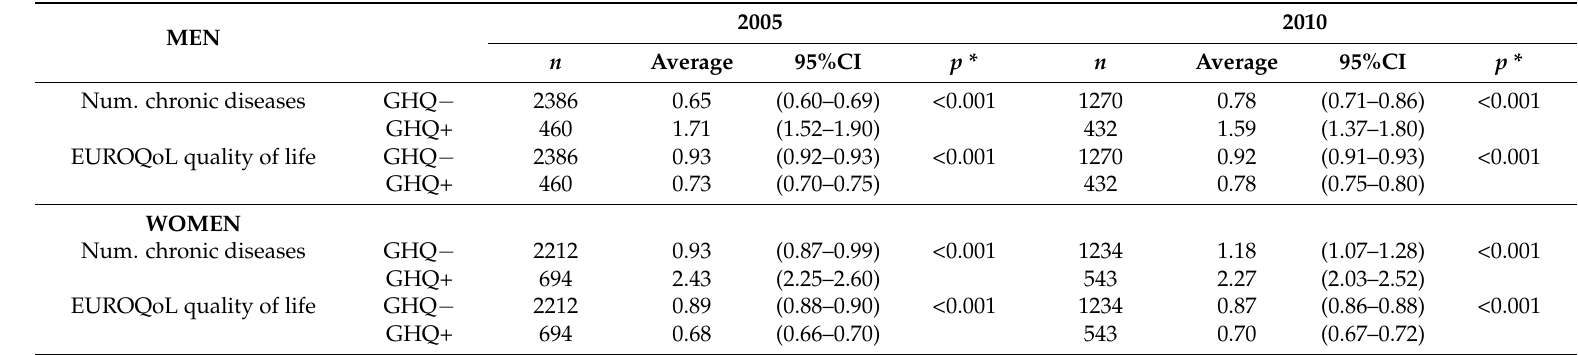
Table 3. Frequencies ( n ), means and confidence intervals at 95% (95%CI) for the quantitative variables studied, according to the risk of poor mental health (GHQ − , GHQ+), by sex and year of the survey.